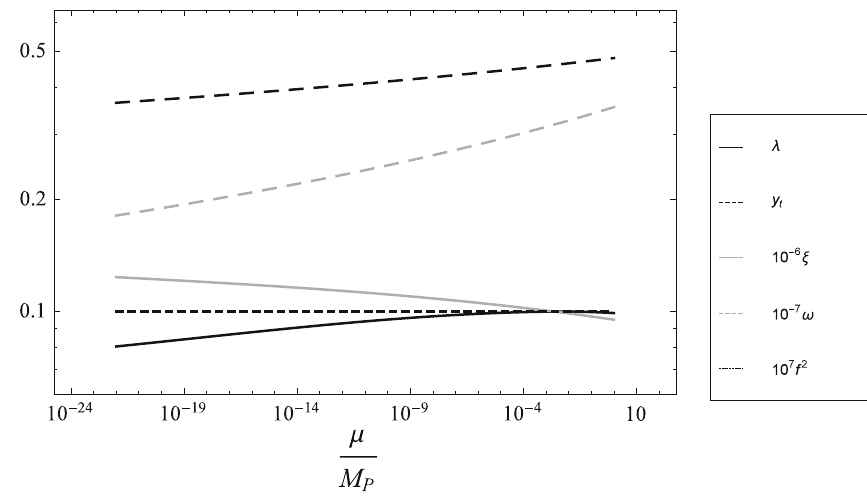
/μ 2 ) in the left 0 . 35 (grey short-dashed line) and 0 . 45 (black long-dashed line). We f took ρ ∗ = 1 . 5 and ξ ∗ = 10 5 . Choosing appropriate ρ ∗ it is possible to make both the scalar and the fermion unrealisable